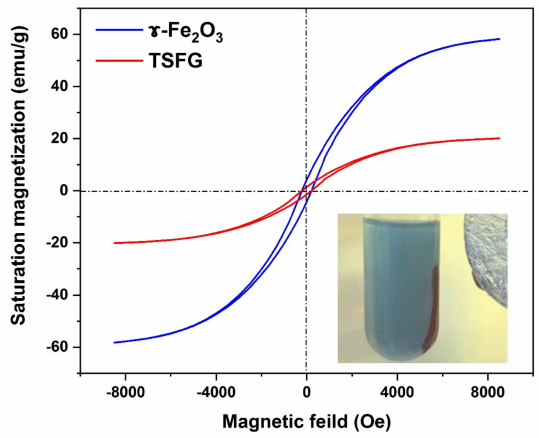
Figure 6. Left: the vibrating sample magnetometer curve of synthesized γ -Fe 2 O 3 and TSFG samples. A photograph of the TSFG nanoparticles separated with a magnetic field is presented on the